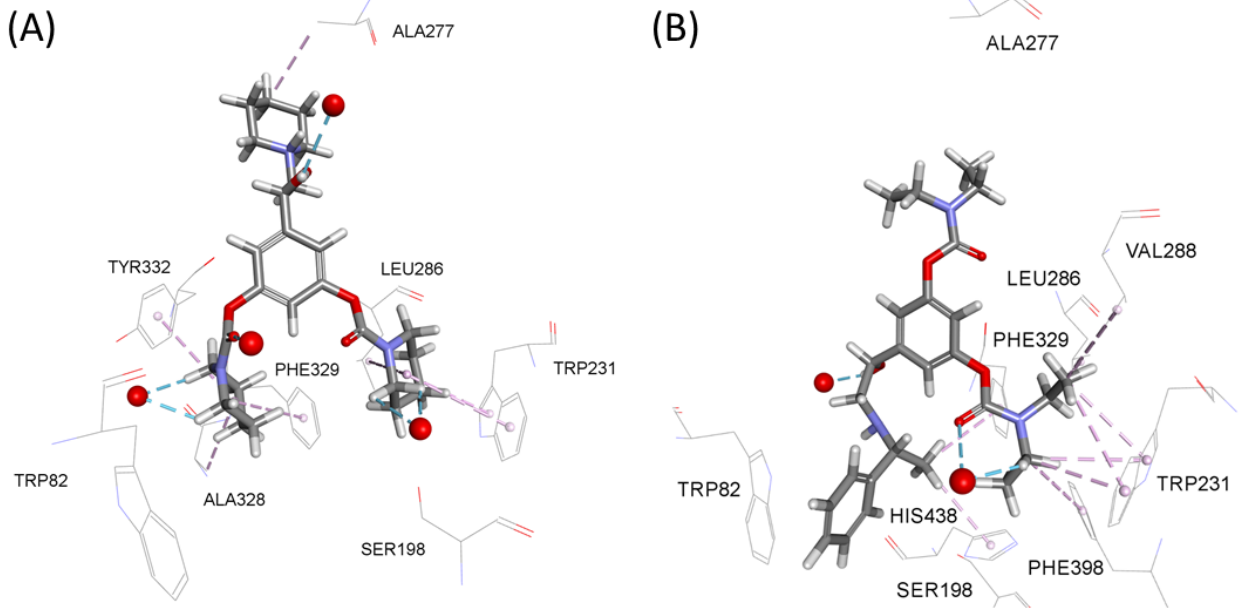
Figure 4. The active site of the model complex between BChE and 16 ( A ) or 10 ( B ). Dashed lines represent different types of non-bonding intermolecular interactions. Red spheres represent conserved water molecules. For clarity, only water molecules predicted to be engaged in non-bonding interactions are shown.